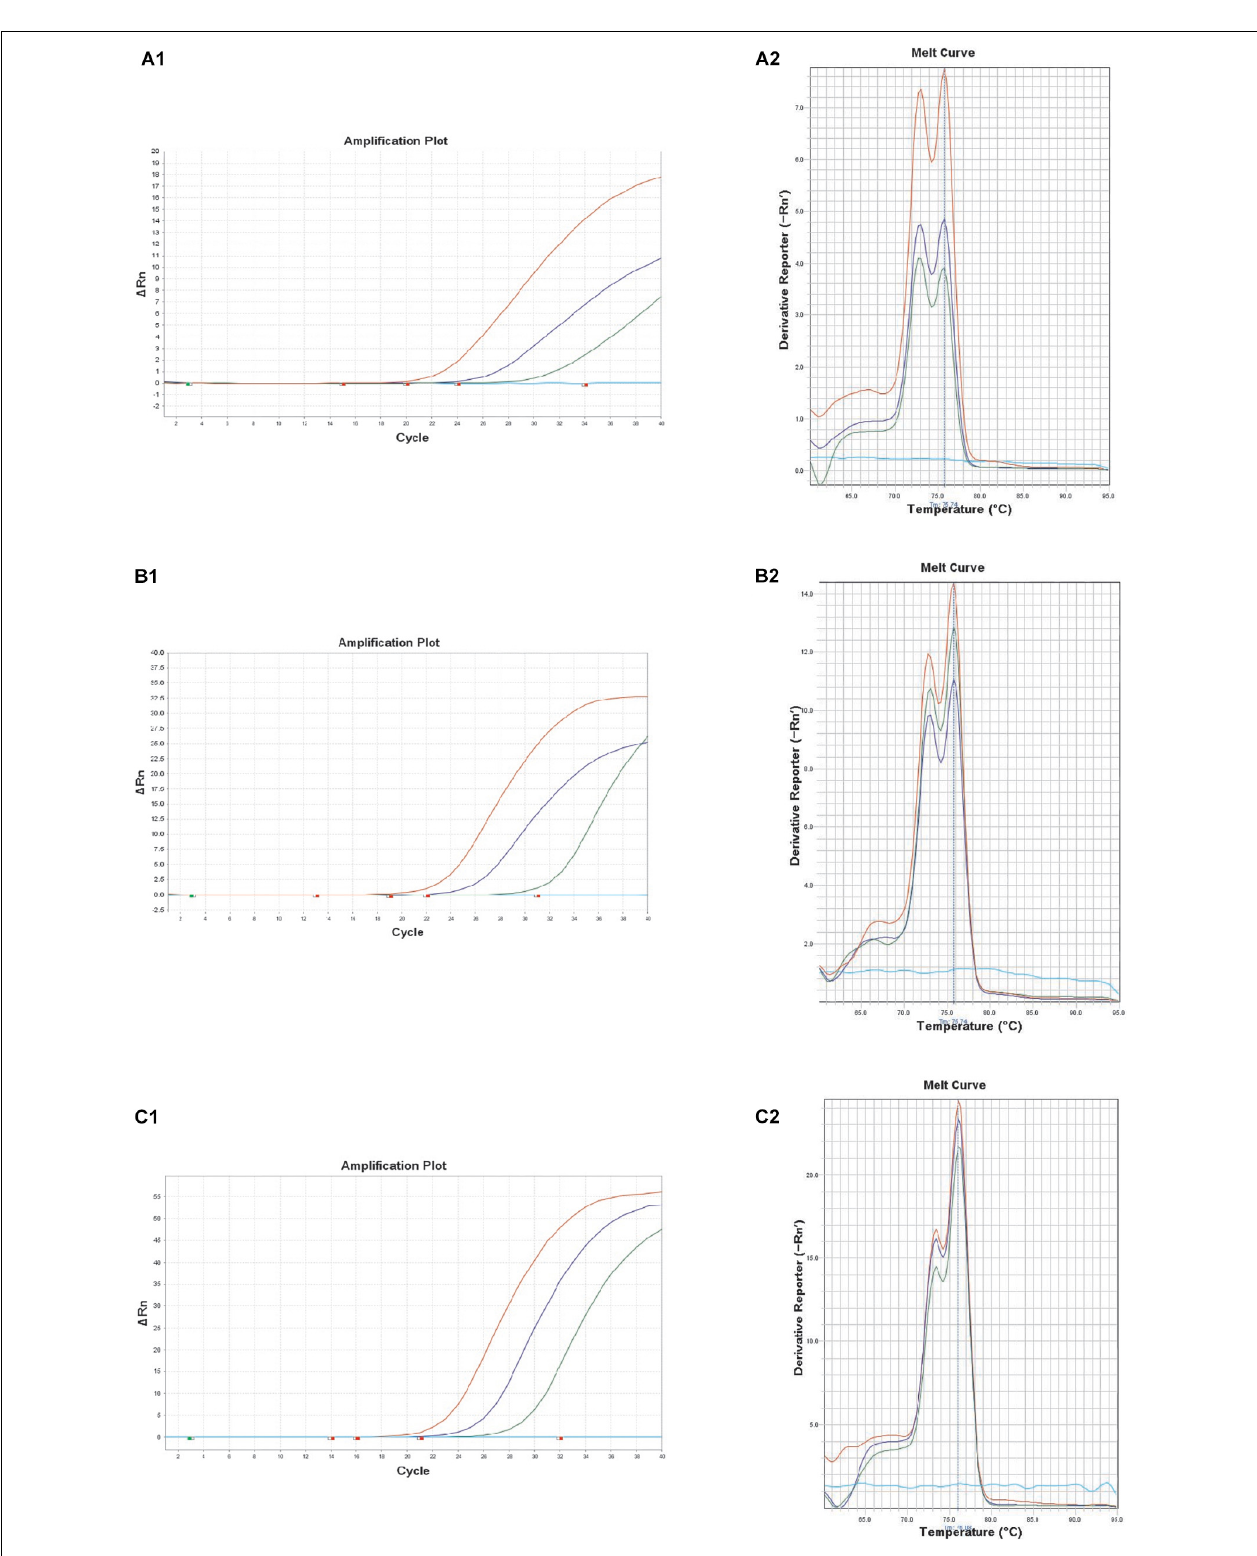
FIGURE 3 | Melt curve peaks and amplification curves of XRE real-time PCR with B. thuringiensis ATCC 10792 in artificially contaminated food samples of lettuce (A1,A2) ; spinach (B1,B2) ; and kimbap (C1,C2). Colony forming units of the amplification curves correspond to 8.4 × 10 2 , 8.4 × 10 1 , 8.4 × 10 0 CFU (lettuce), 9.0 × 10 2 , 9.0 × 10 1 , 9.0 × 10 0 CFU (spinach), and 2.4 × 10 2 , 2.4 × 10 1 , 2.4 × 10 0 CFU (kimbap), respectively.